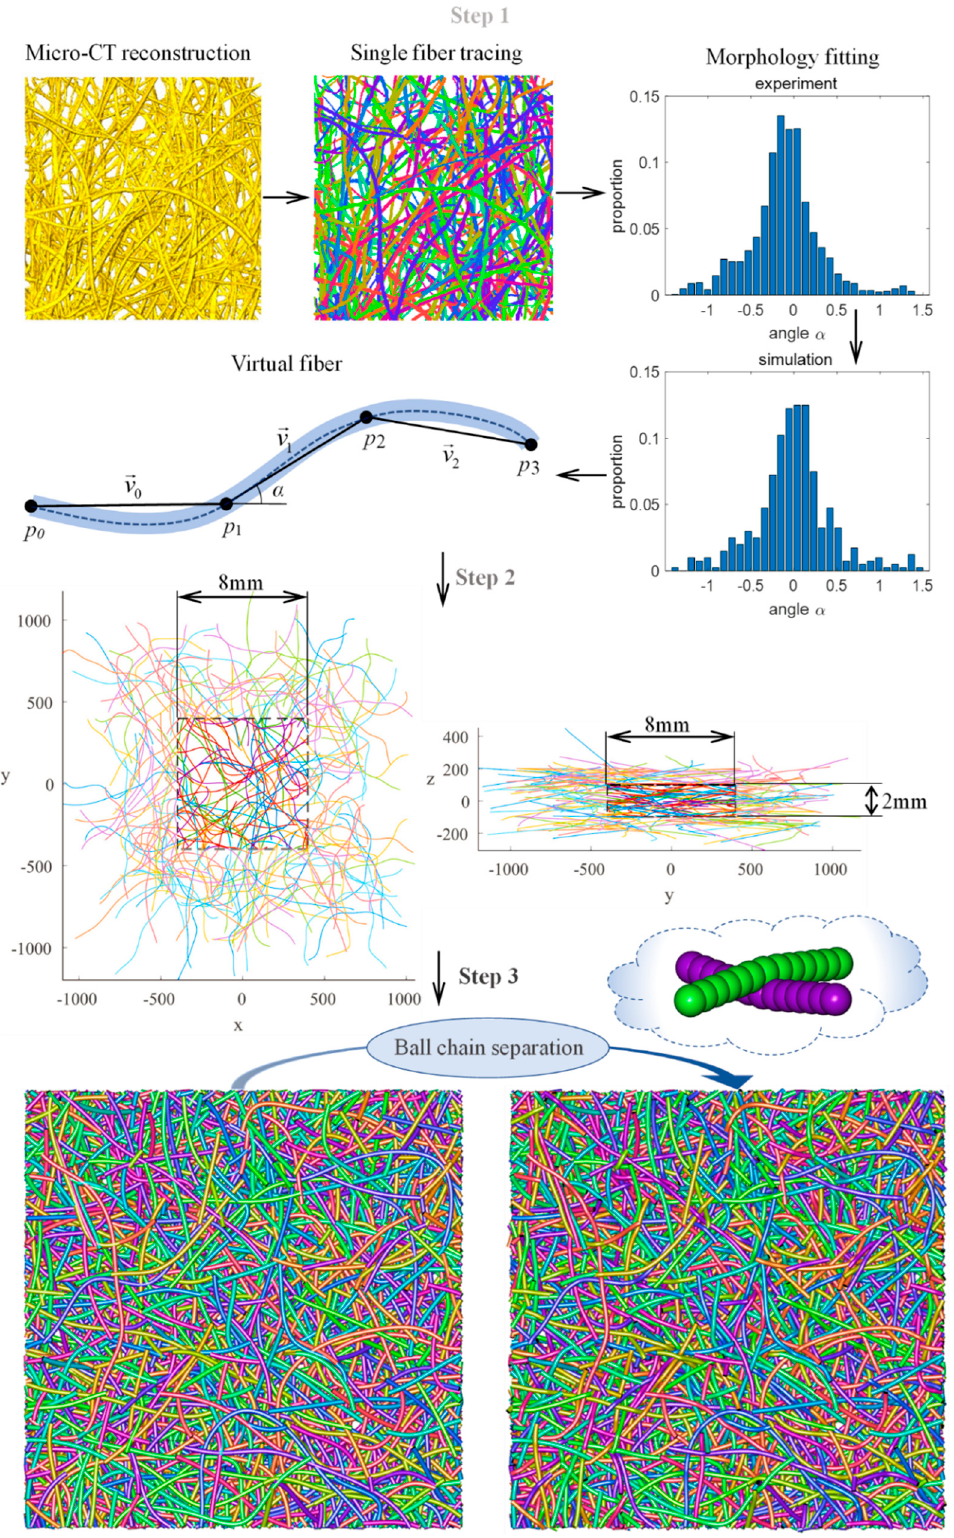
Figure 2. Generation of virtual PMFSS divided into three stages. Step 1: single fiber simulation, step 2: fiber accumulation, and step 3: fiber separation.